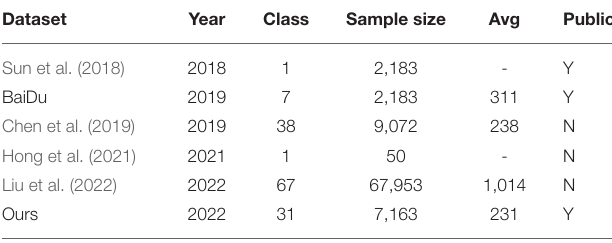
TABLE 5 | Model parameter settings of Deformable